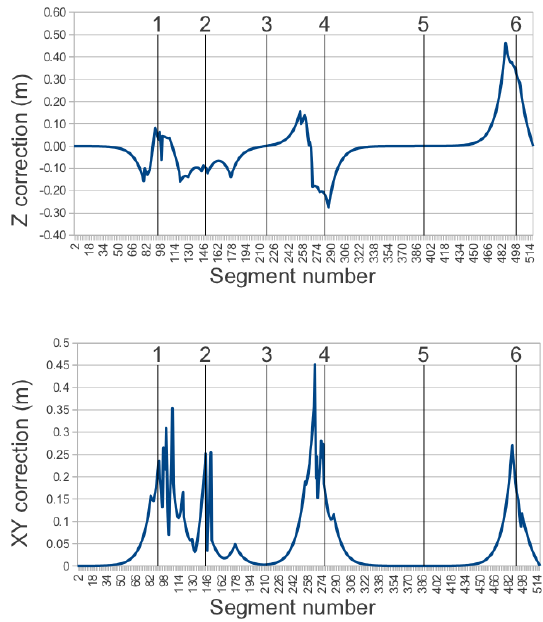
Figure 7: Results of the global compensation procedure. Areas of interest are indicated in Figure 6